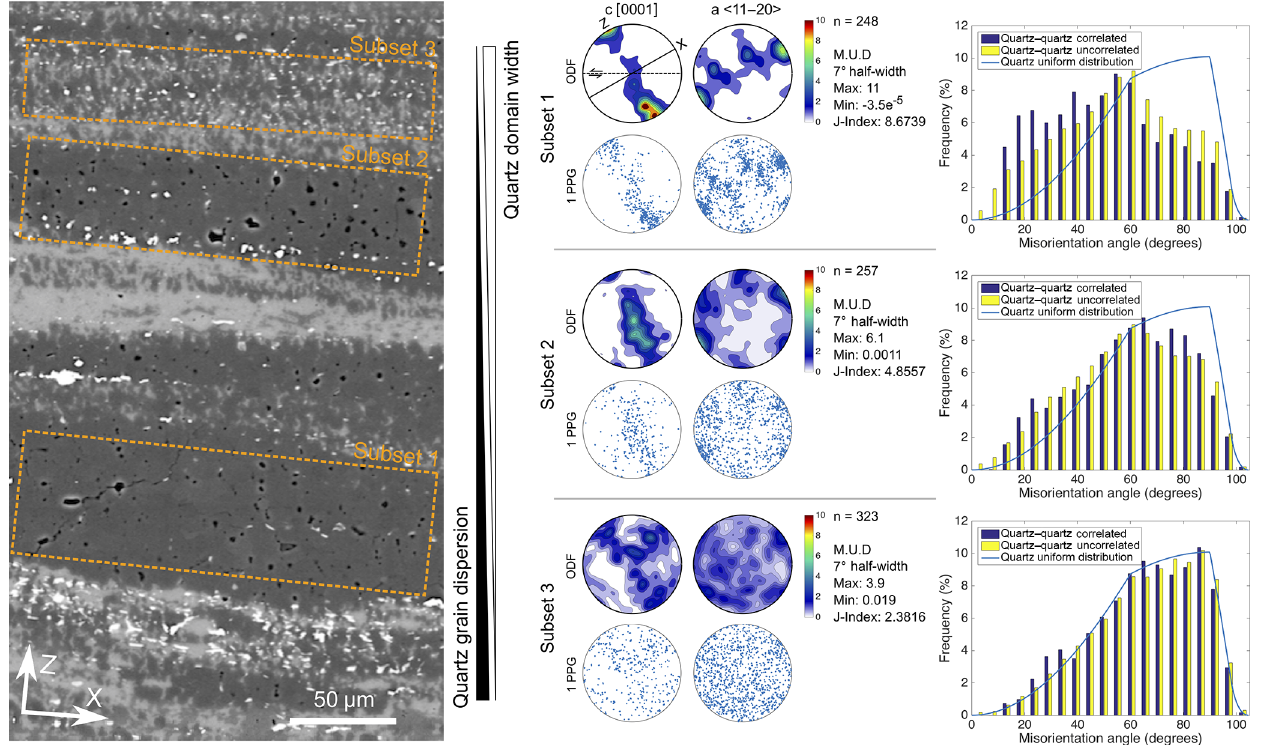
Figure 9. EBSD subset analyses of quartz domains. The EBSD analyses were preformed in the same quartz bands used for subset image analysis (see Figs. 1 and 5). EBSD data are presented in equivalent subsets corresponding to decreasing quartz domain width and increasing quartz dispersion. A clear CPO is observed in the pole figure analysis of subset 1 with two c[0001] maxima and two corresponding a < 11– 20 > maxima. As quartz domain thickness decreases there is a randomisation of the CPO highlighted by the decrease in the J -Index and supported by the shift to a nearly random distribution of the misorientation angle histogram of subset 3. Note that only grain-boundary data are presented in the misorientation angle histograms. Subgrains and Dauphine twin boundaries are excluded from the visualisation.